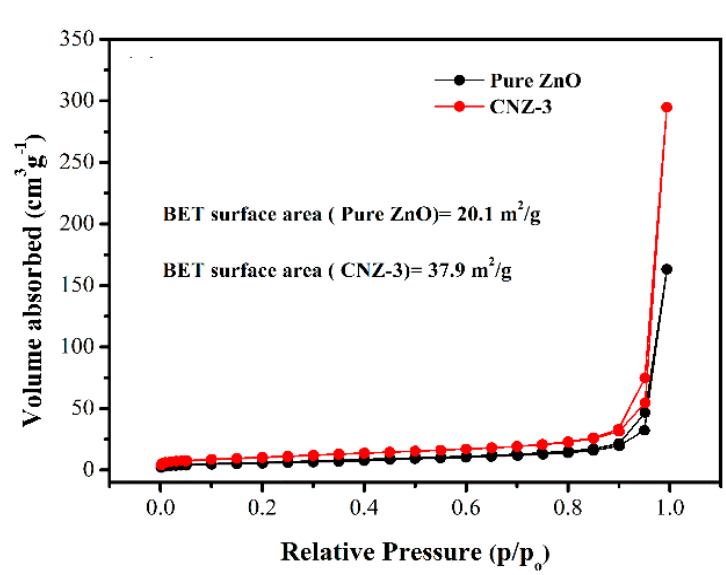
Figure 6. N 2 adsorption-desorption isotherms.